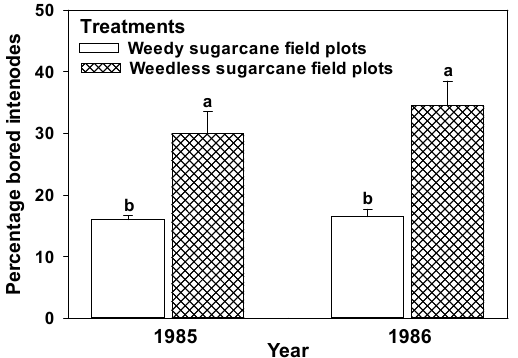
Figure 4. Mean (± SE) percentages of sugarcane internodes bored by Diatraea saccharalis in weedy and weedless sugarcane field plots at harvest during two growing seasons, Assumption Parish, Louisiana; significant ( p < 0.05) differences are indicated by different letters over the bars [22].